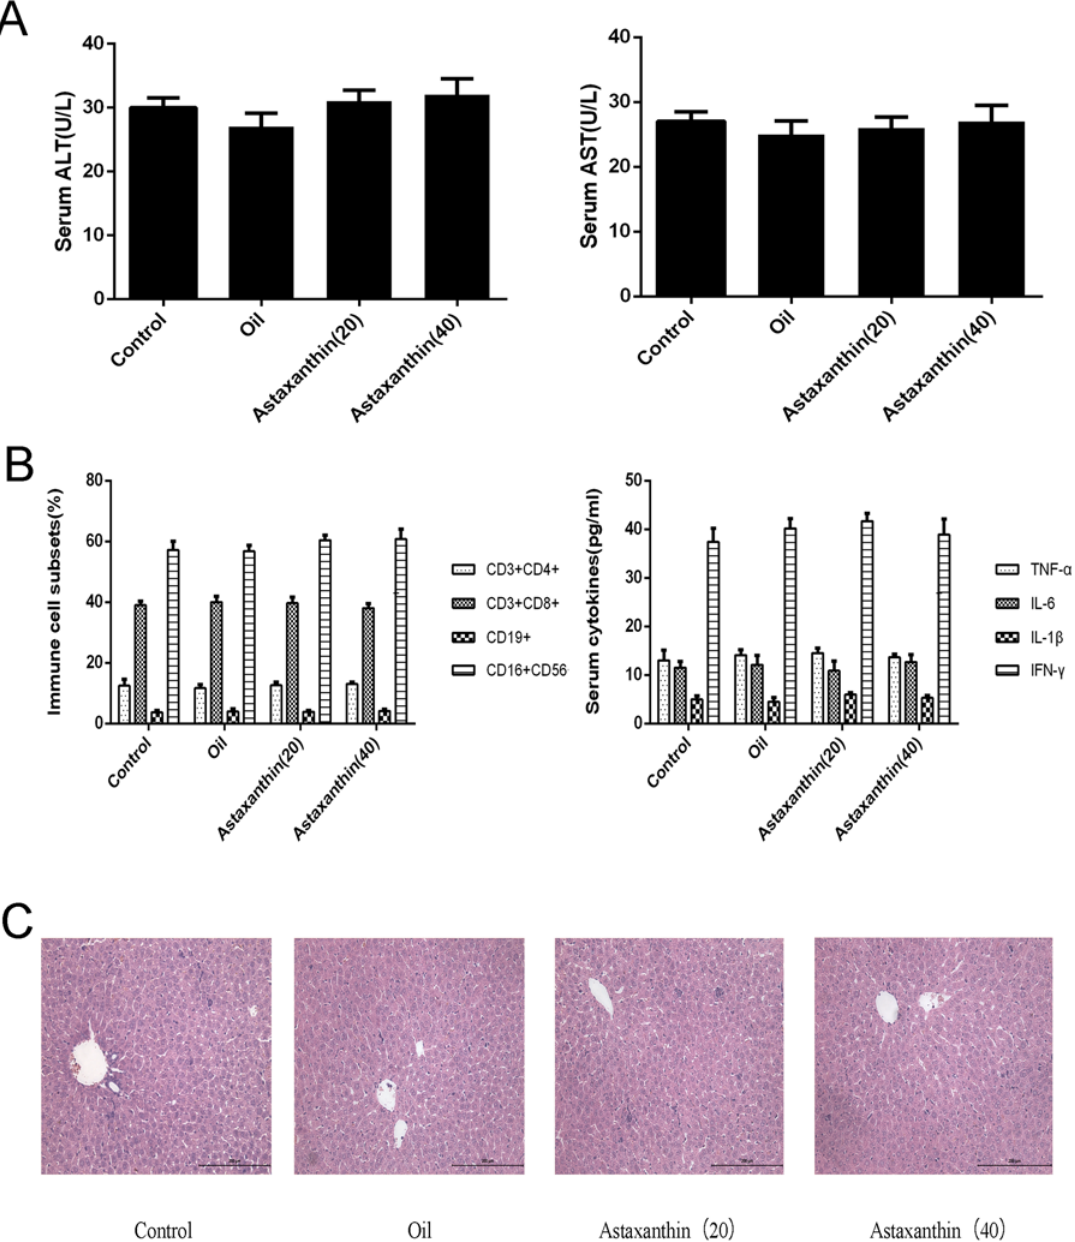
Fig 1. Effects of olive oil and astaxanthin on the liver function and pathology of healthy mice. (A) The levels of serum ALT and AST in the four groups did not differ. Data are given as means ± SD (n = 6, P > 0.05). (B) The percentage of different immune cell subsets, serum levels of TNF- α , IL-6, IL-1 β , and IFN- γ of four groups were evaluated in each group with ELISAs or flow cytometry (n = 6, P > 0.05). (C) Representative hematoxylin-and-eosin-stained sections of the liver. Original magnification, ×200.